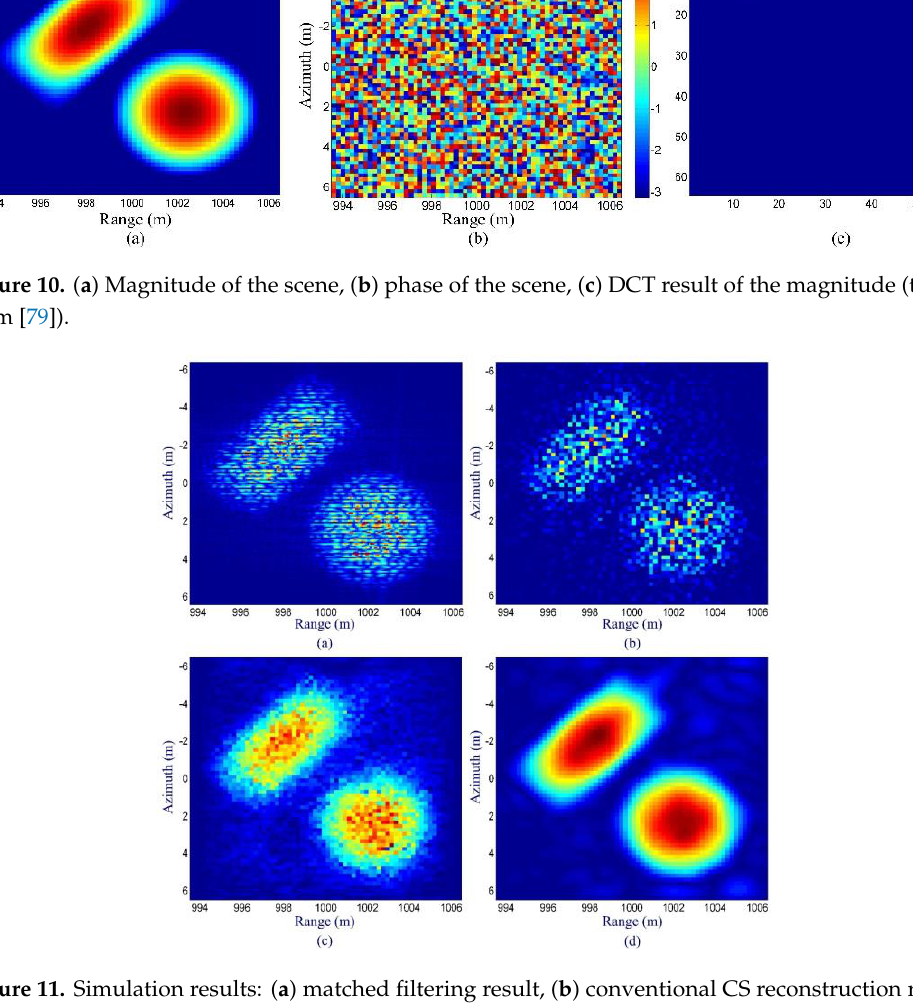
Figure 11. Simulation results: ( a ) matched filtering result, ( b ) conventional CS reconstruction result without sparse representation, ( c ) result of the method with magnitude sparse representation, and ( d ) result of the method with improved magnitude sparse representation (taken from [79]).